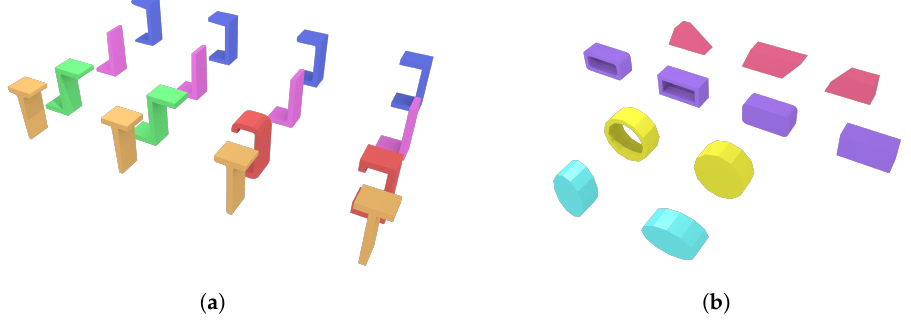
Figure 2. IFC defines various types of parametric curved profiles such as ( a ) those based on the characters U, L, Z, C and T and ( b ) those based on trapezia, (rounded) rectangles, circles with/without holes and ellipses. Note the various types of tapered and curved parts of the profiles. These are most commonly used in extrusions such as those shown